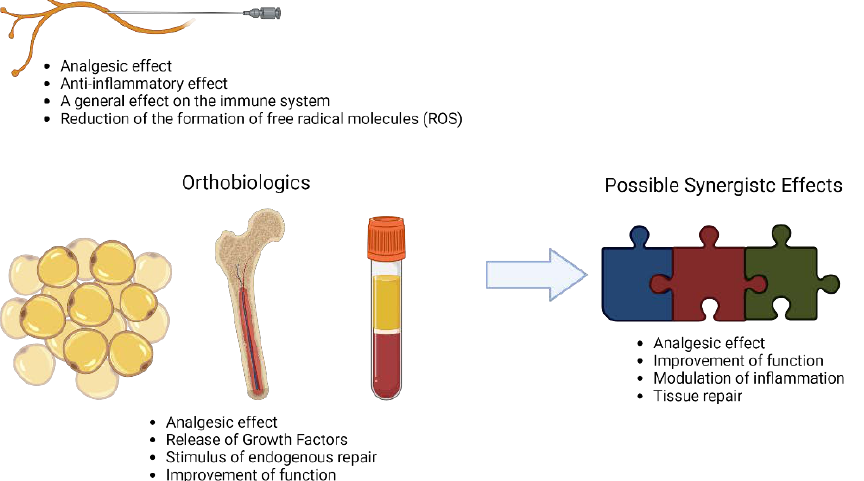
Figure 2. Synergistic proposal effects of PRF combined with orthobiologics. Created with BioRen- der.com, accessed on 6 September 2022.